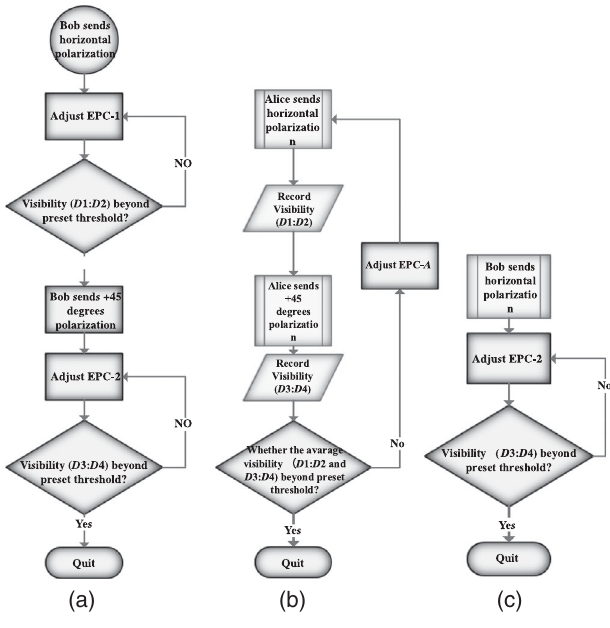
FIG. 14. Flowchart of polarization alignment.